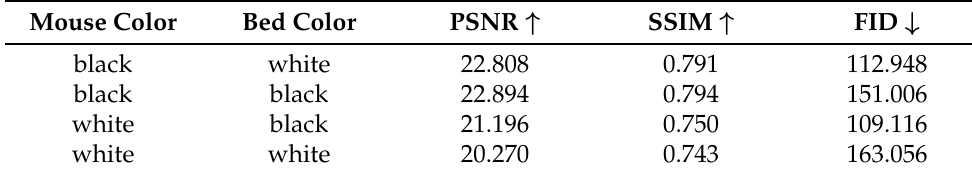
Table 4. Metrics of the pix2pix Cross Entropy model on the different combinations of mouse and bed